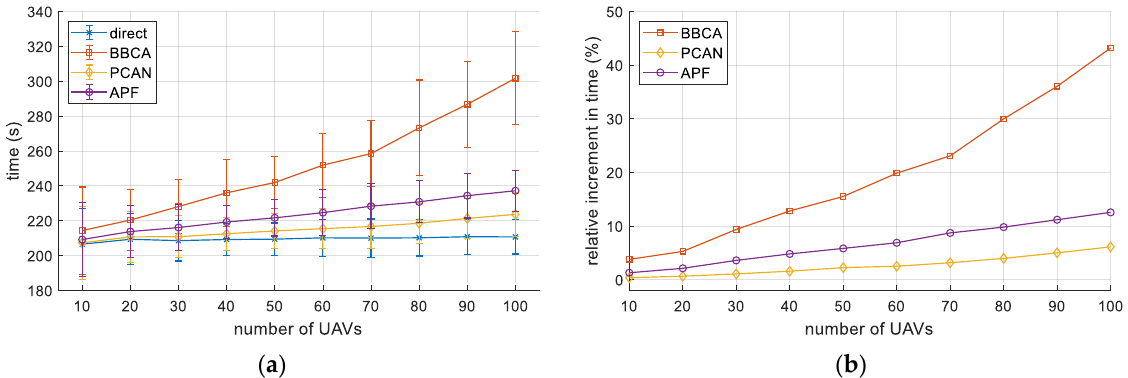
Figure 13. Multi-UAV study. Flight time: ( a ) absolute values (mean and standard deviation); ( b ) relative increase with